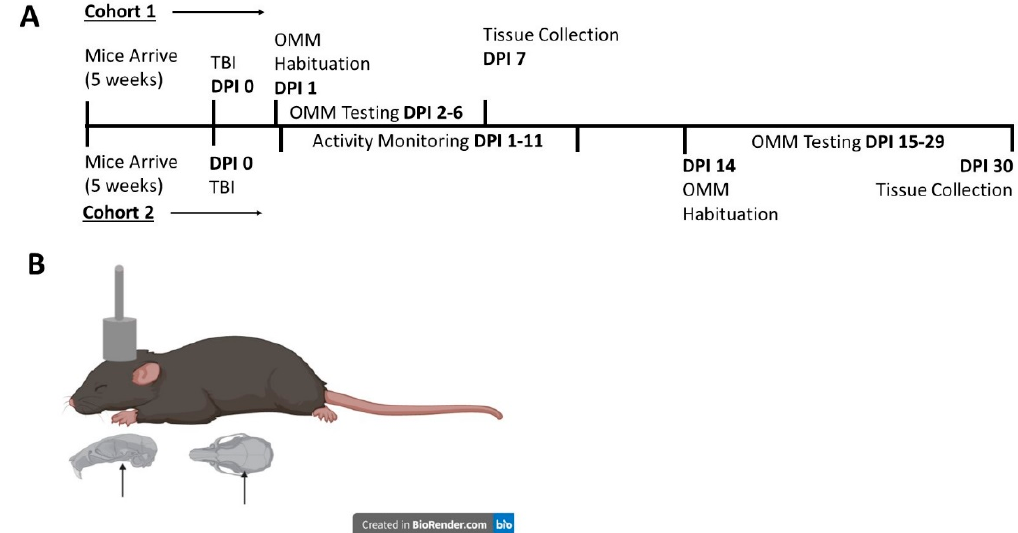
Figure 1. Experimental outline. Two cohorts of mice were utilized in this study. ( A ) shows a timeline for described experiments. ( B ) shows an estimate of our weight drop location with scalp intact. Arrows indicate the location of bregma. OMM = Optomotor Machine. Images in ( B ) were created in BioRender at BioRender.com.